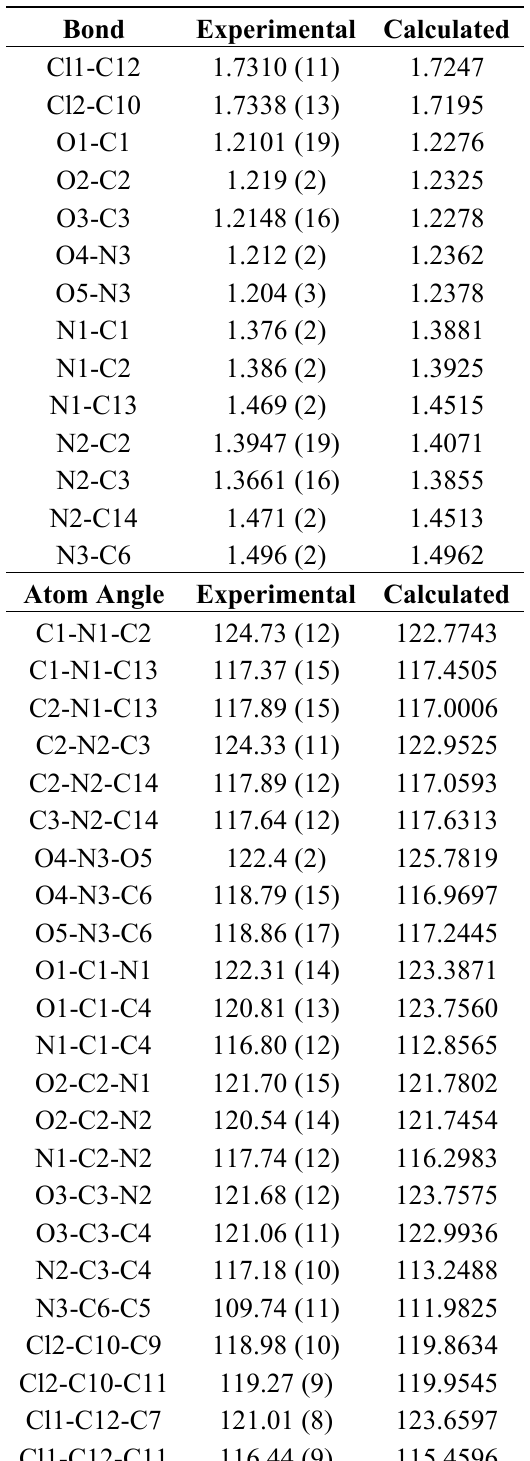
Table 6. Selected geometric parameters (Å, °) of compound 2b